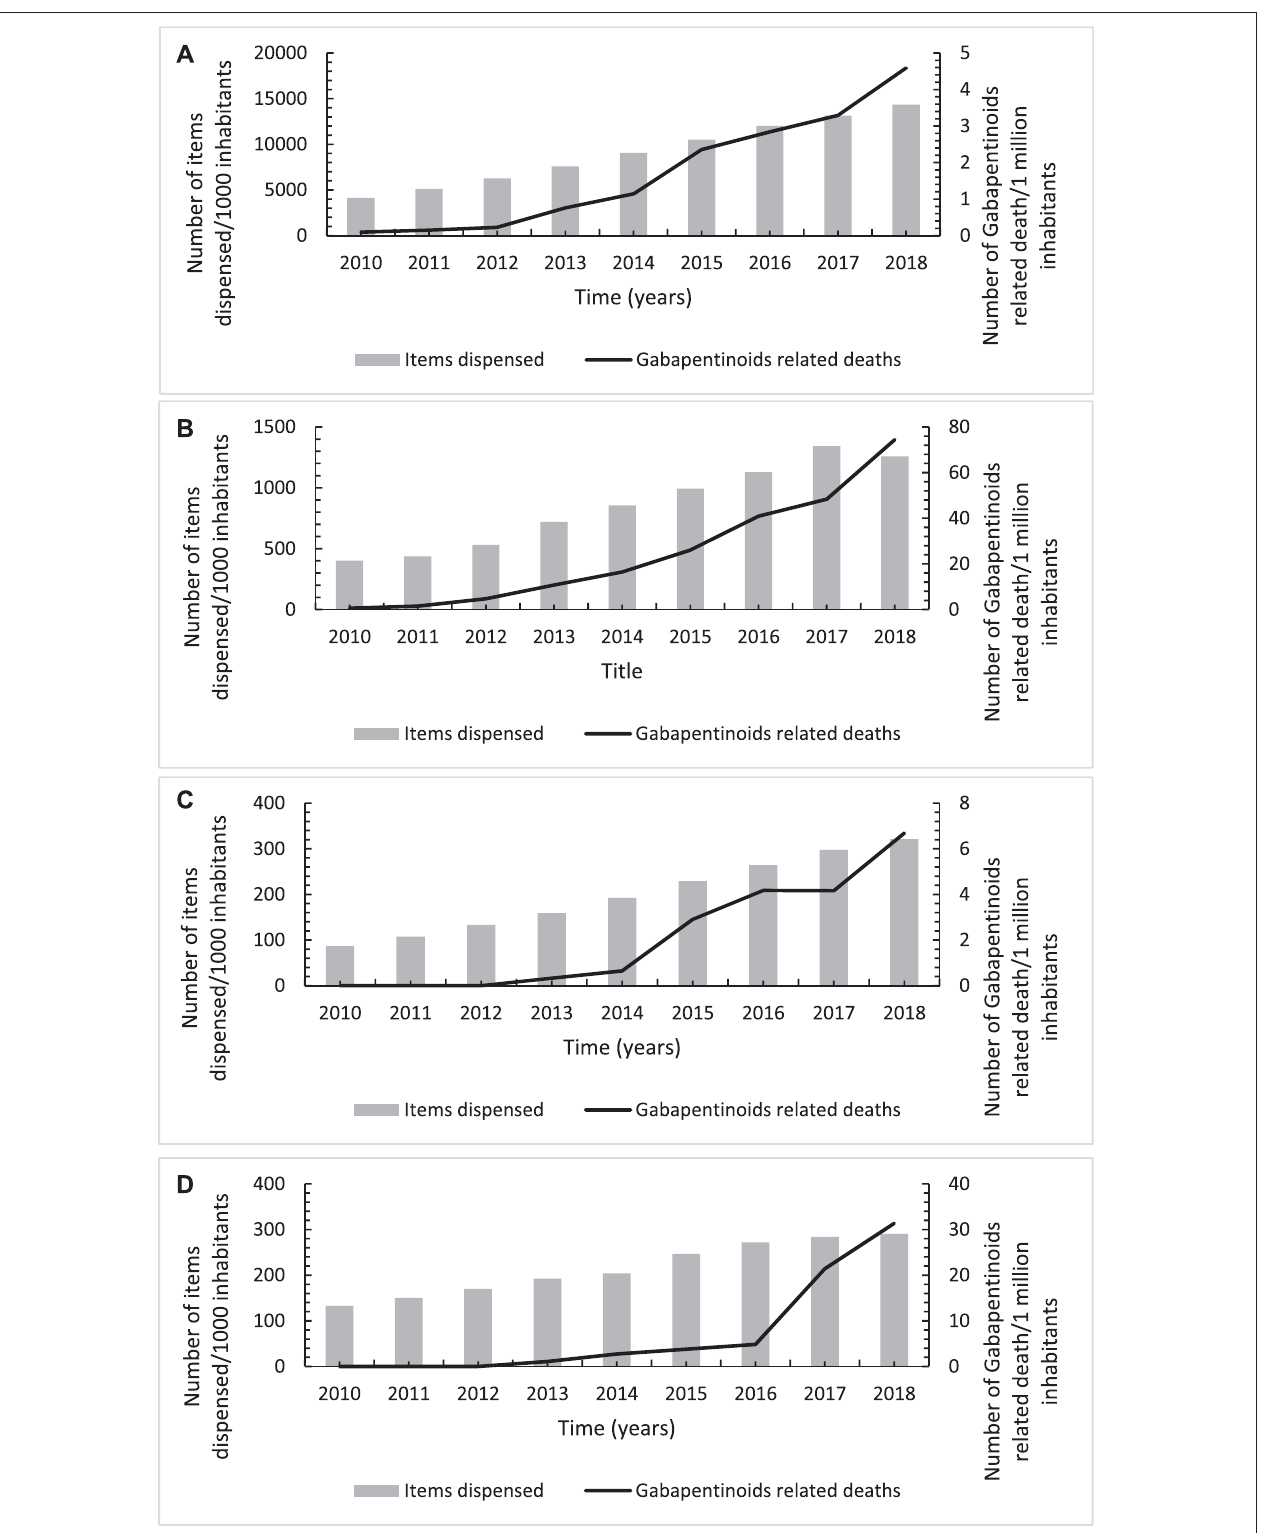
FIGURE 7 | Annual trends in number of gabapentinoids-related deaths per one million inhabitants in association with its utilisation trends across England (A) , Scotland (B) , Wales (C) and Northern Ireland (D) over the study period from 2010 to 2018.